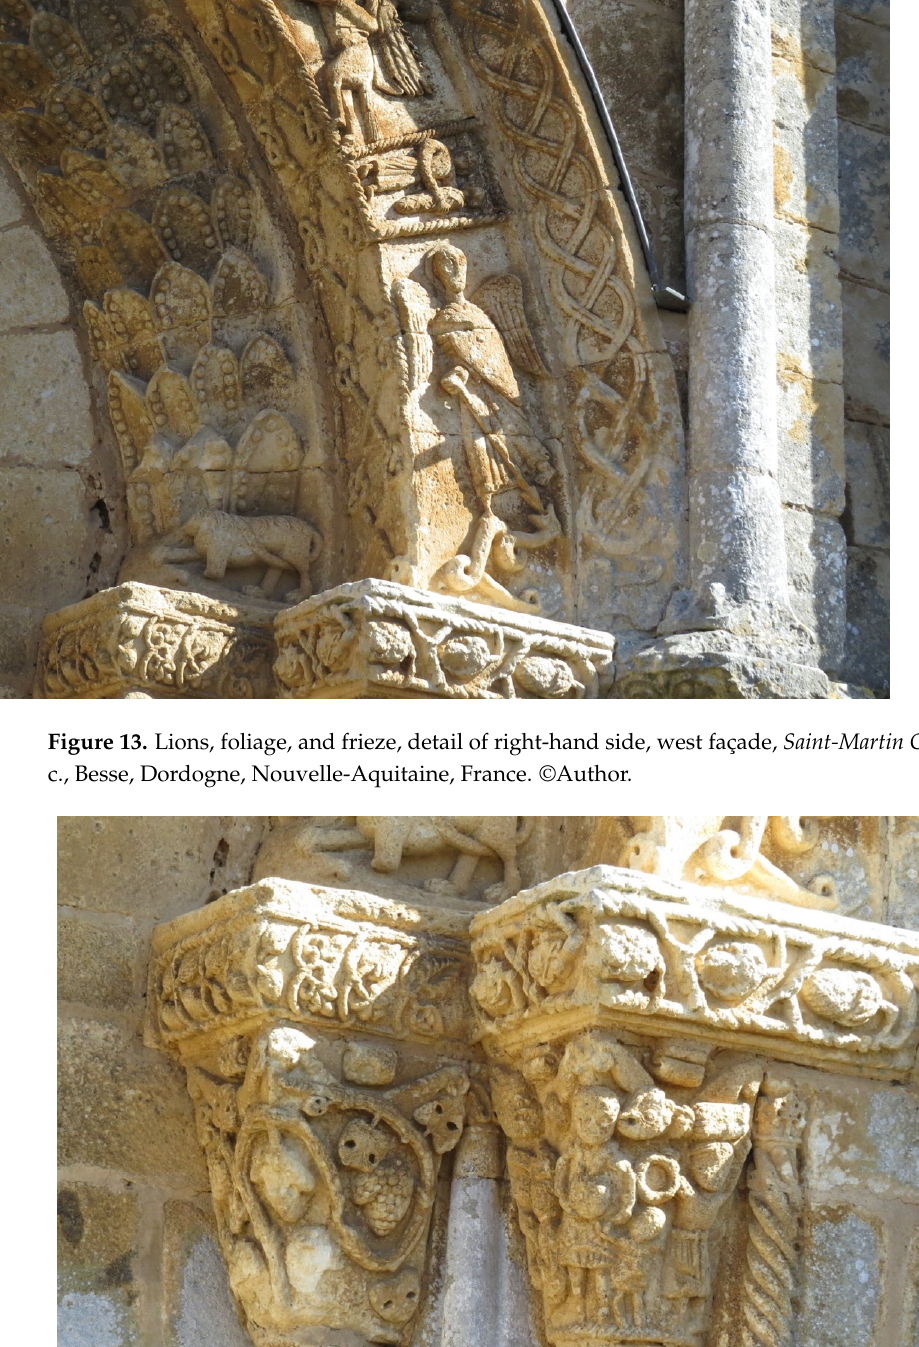
Figure 15. Saint-Martin Church , west façade, 12th c., Besse, Dordogne, Nouvelle-Aquitaine, France. ©Author.